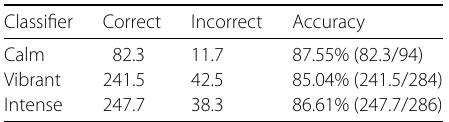
Table 4 This table shows the total number of songs in the test-set for each classifier, the average number of misclassified songs, and the average percentage of misclassified songs per activity group, which resulted from 10-fold cross validation for each